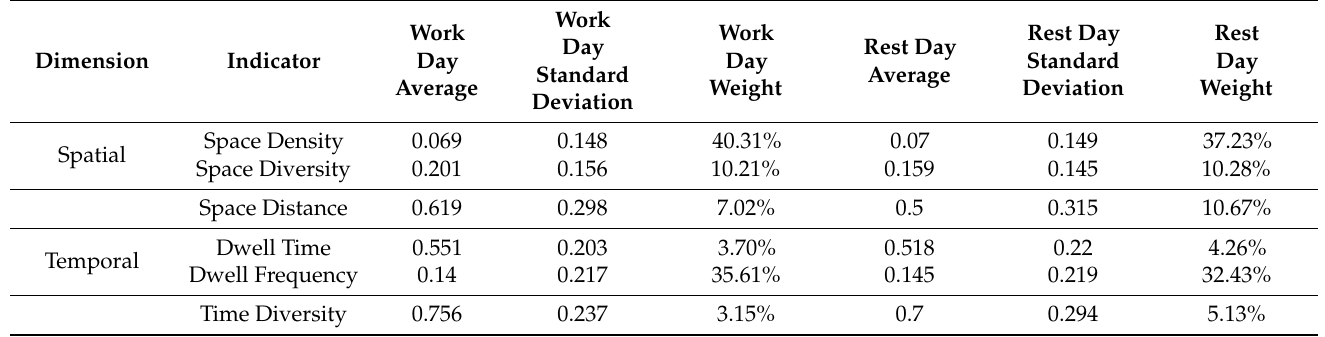
Table 4. The weight distribution of the attractiveness indicators of the riverside area of Wuhan.